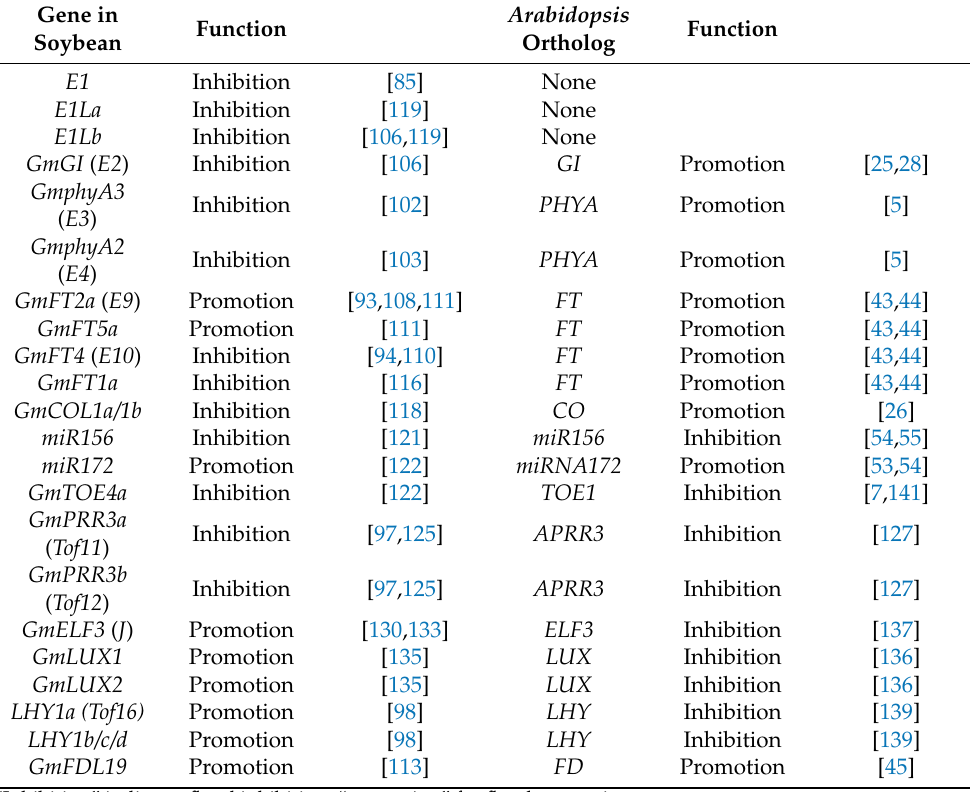
Arabidopsis Function Ortholog